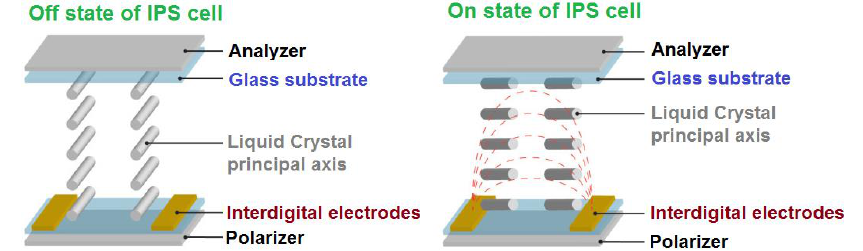
Figure 1. Off and on states of an in-plane switching (IPS) nematic liquid crystal (NLC) cell. Red dashes show the lines of force of the electric field E .